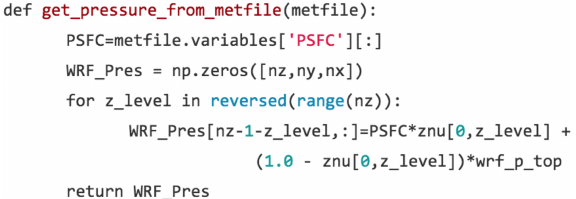
Figure A1. A Python script, which reconstructs the pressure using the met_em_...* files. nx, ny, and nz indicate the number of grid nodes in WRF-Chem